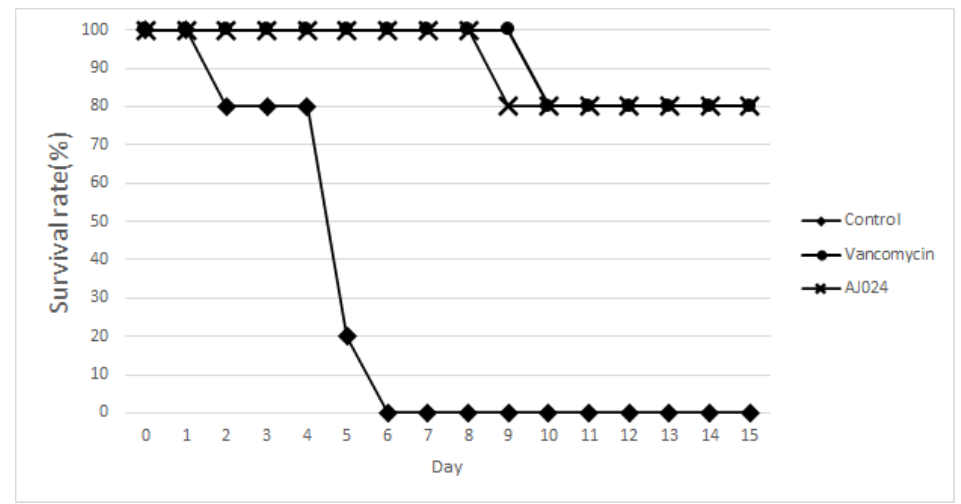
Figure 4. Survival rate of AJ-024 in treatment of C. difficile in mouse.